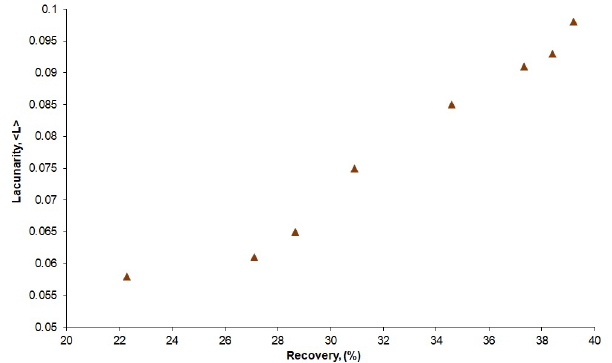
Figure 9. Lacunarity vs. Recovery plot for deterministic fractal- fracture patterns ( i = 1 to